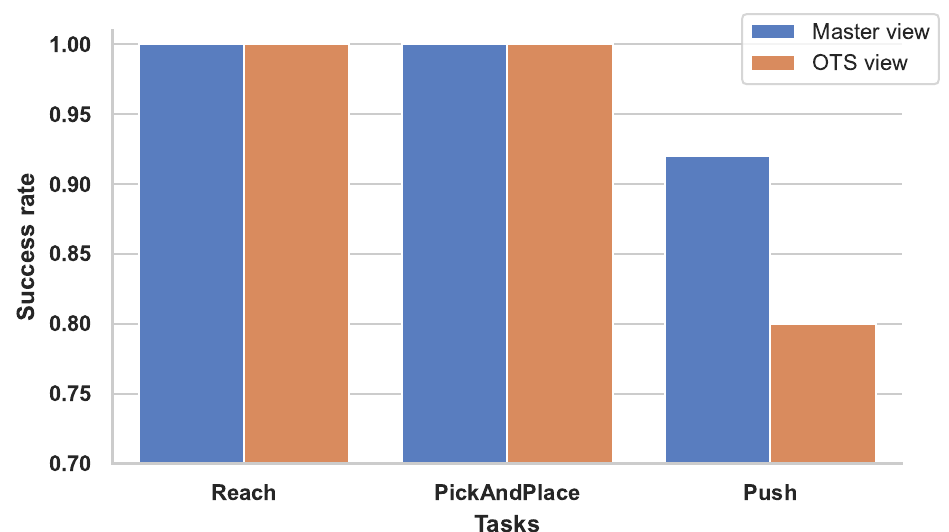
Figure 8. Performance of third-person view ablation. Policy performances (success rate) of dual- camera view with master view and OTS view in whole three tasks; statistical data of 25